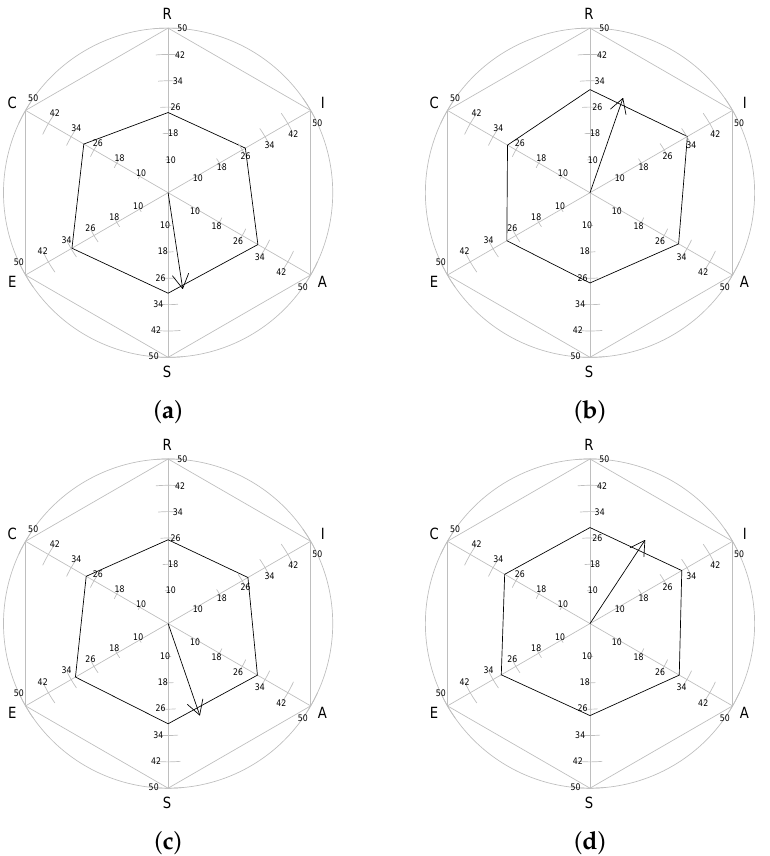
Figure 4. Circular graphical visualizations for mean aggregated interests score profiles with resulting mean interests vector V ; upper panel ( a,b ): Subsamples mean splitted by Iachan [50] index, (( a ): bel- low mean, V = 171.38 ◦ , ( b ): above mean, V = 19.22 ◦ ); lower panel ( c,d ): Subsamples mean splitted by Hamming distance [61] index, (( c ): above mean, V = 160.96 ◦ , ( d ): below mean, V = 33.39 ◦ ); all values in degree clockwise starting at dimension Realistic